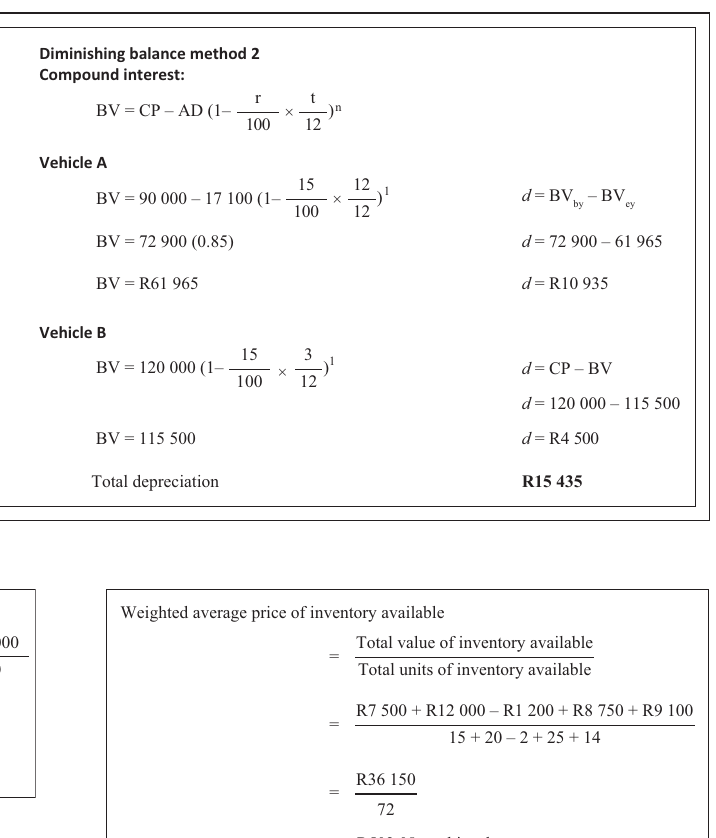
= R502.08 FIGURE 26 : Formula – weighted average price of inventory available.